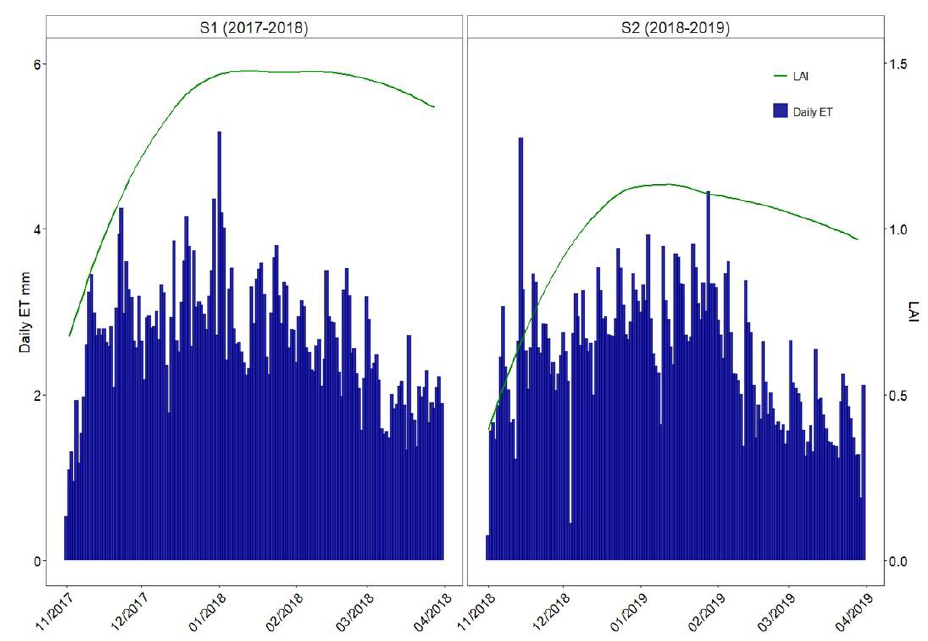
Figure 5. Total daily evapotranspiration of the vineyard (Daily ET) and Leaf Area Index ( LAI EA )